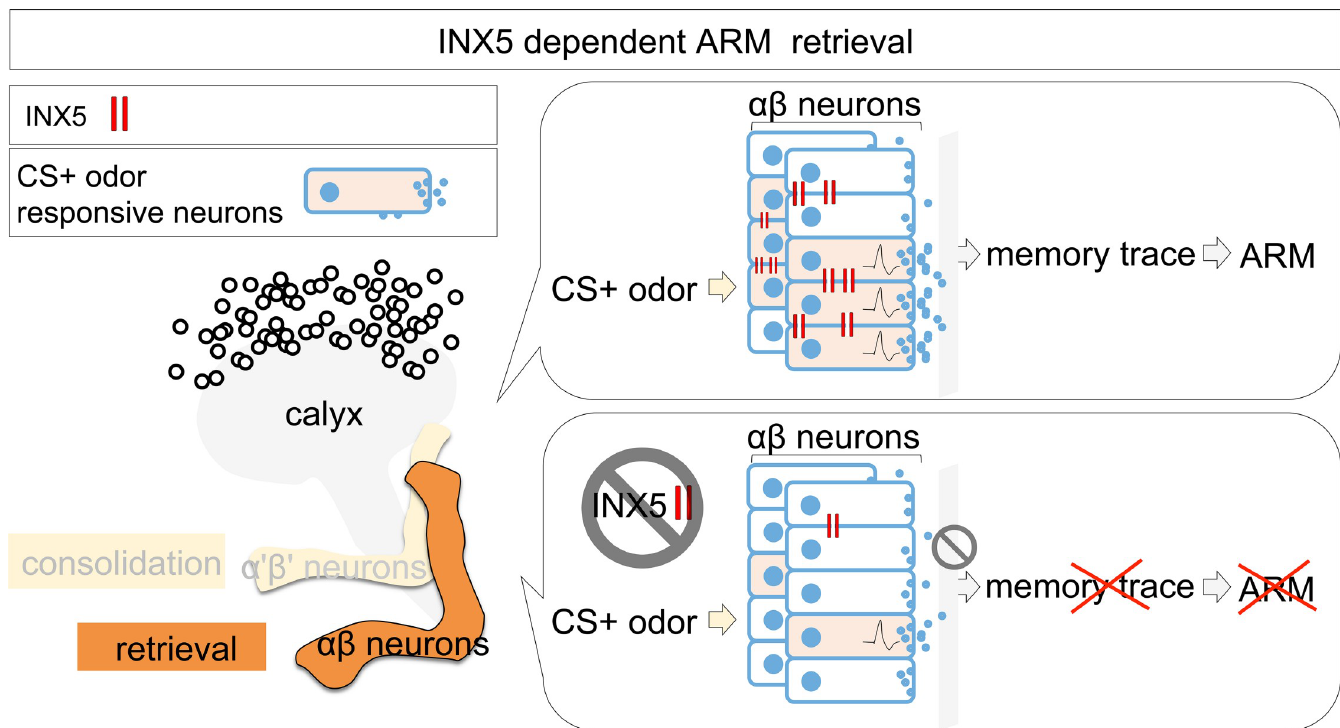
Fig 7. Hypothetical model of the role of INX5 in ARM retrieval. After training, the permeability of gap junction channels composed of INX5 is increased in αβ neurons via an unknown mechanism. During ARM retrieval, INX5 gap junctions propagate the action potential and synchronize the firing of αβ neurons, which contributes to an increase in the proportion of odor responsive αβ neurons to the training odor (CS+ odor). The odor responsive αβ neurons boost the synaptic output strength that induces the relevant branch-specific modification of calcium influx in αβ neurons to the CS+ odor (memory trace). Inhibiting the gap junction channels reduces the proportion of odor responsive αβ neurons to the CS+ odor during memory retrieval, which disrupts branch-specific memory traces and ARM.